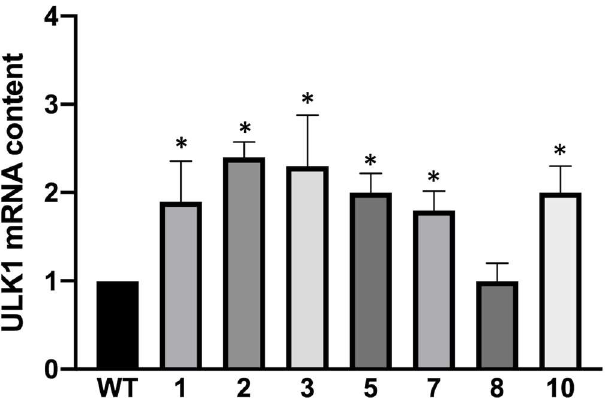
Figure 7. Summary representing the mean ULK1 mRNA content found in K562 wild-type cells and obtained clones (mean ± SD; N = 3); ULK1-dependent autophagy is linked to α-globin hyper-expression. p < 0.05 (*).